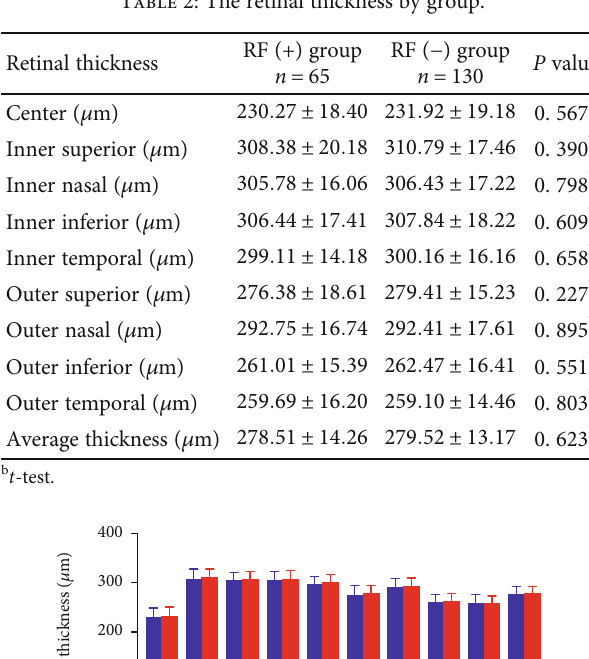
Table 2: The retinal thickness by group.